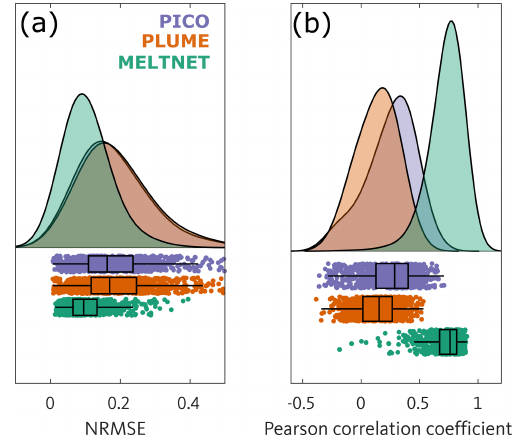
Figure 4. Distributions of NRMSE (a) and Pearson correlation coefficient (b) for the three different melt rate parameterisations: PICO (violet), PLUME (orange) and MELTNET (green). The lower section of each panel shows each individual score from the entire test set, overlain with a box plot. The box represents the interquar- tile range of scores, and the vertical line through the box is the me- dian. The upper section of each panel presents the same information as probability density plots. Note lower NRMSE and higher corre- lation coefficient mean a better fit to the ground truth NEMO melt